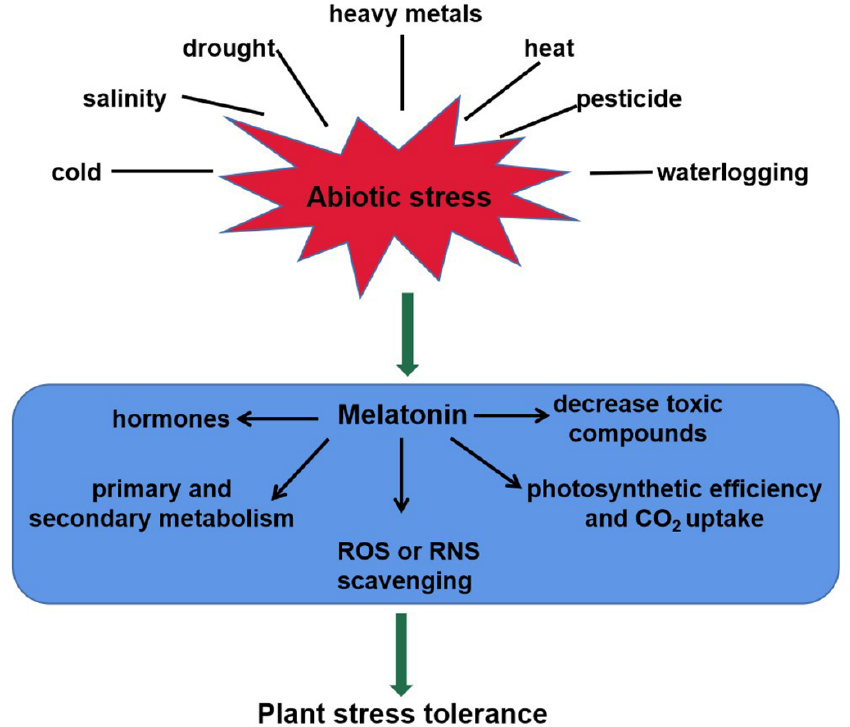
Figure 2. The roles of melatonin in plant tolerance to abiotic stress. Melatonin content of plants increases significantly in responses to abiotic stresses, such as heavy metals, salinity, drought, heat, cold, waterlogging, and pesticides. It confers plant tolerance via multiple mechanisms, including ROS or RNS scavenging, toxic compounds decrease, photosynthetic efficiency increase, interaction with hormones, and secondary metabolite biosynthesis. ROS, reactive oxygen species; RNS, reactive nitrogen species.